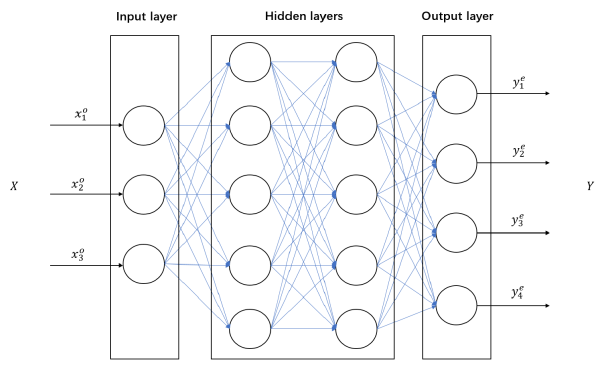
Figure 1. The structure of